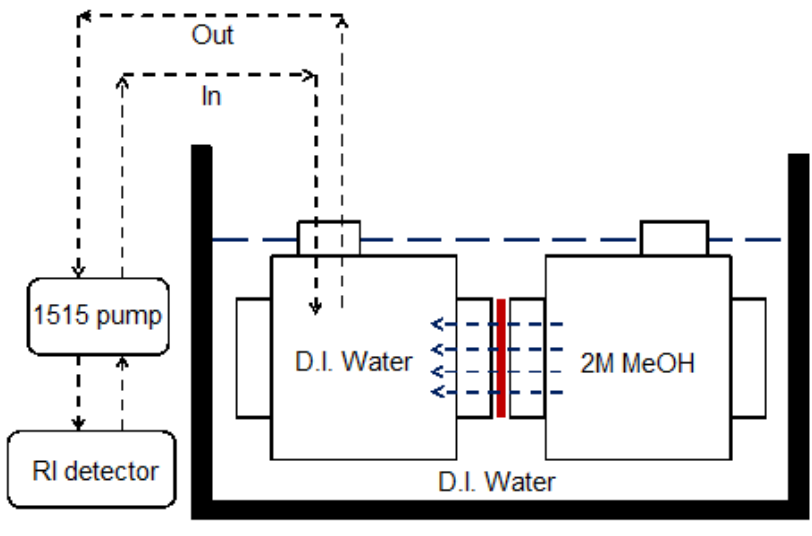
Figure 4. Schematics of two chambers for methanol permeability